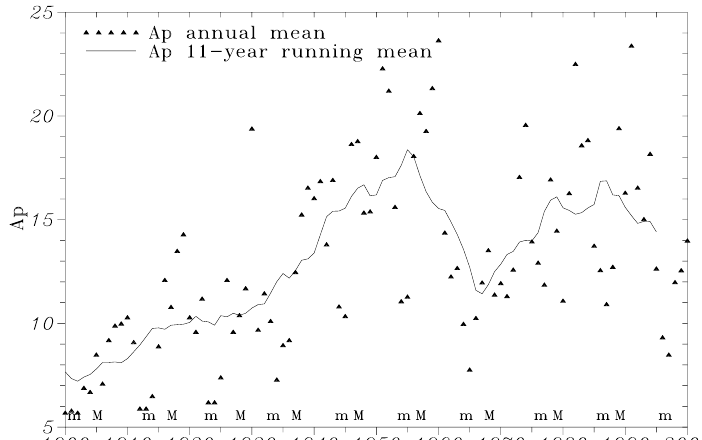
Fig. 5. Annual mean and 11-year run- ning mean Ap index variations during the 20th century. Annual mean Ap in- dices prior to 1932 were reconstructed from aa indices available since 1868. Symbols (m) and (M) refer to years of solar cycle minimum and